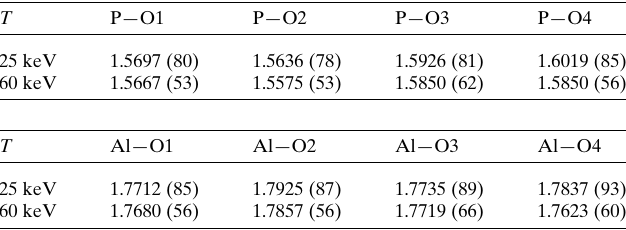
Table 3 Bond lengths for both T sites for the data sets with thresholds of 25 keV ( T = 25 keV) and 60 keV ( T = 60